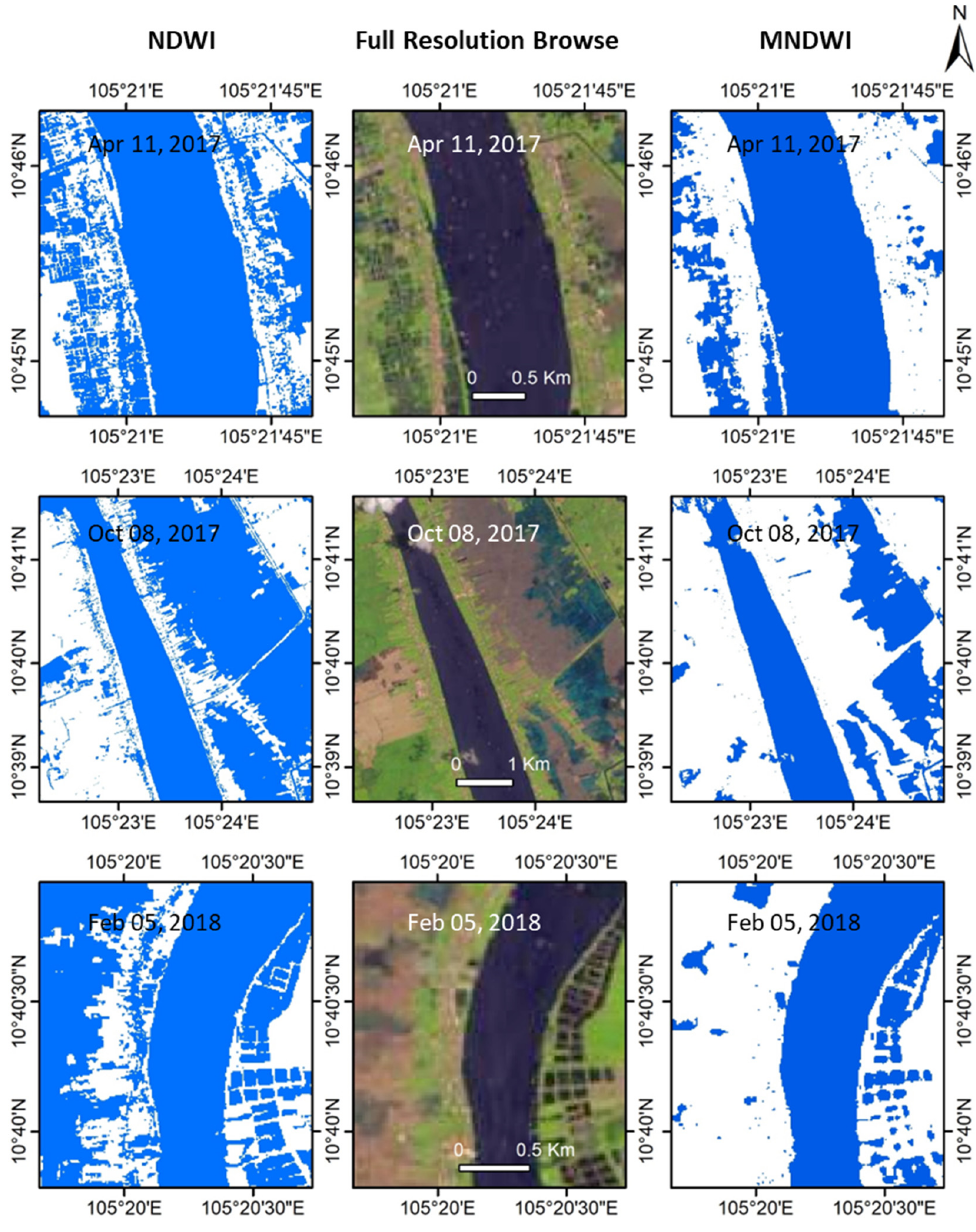
Figure 12. A comparison of surface water maps using the automatic Otsu threshold on the Sentinel-2 NDWI and MNDWI images for three main periods similar to Figure 10. The left column is water detection (blue color) using the automatic Otsu method on the NDWI images. The middle column is the Sentinel-2 Full Resolution Browse images. The right column is water detection (blue color) using the automatic Otsu method on the MNDWI images.